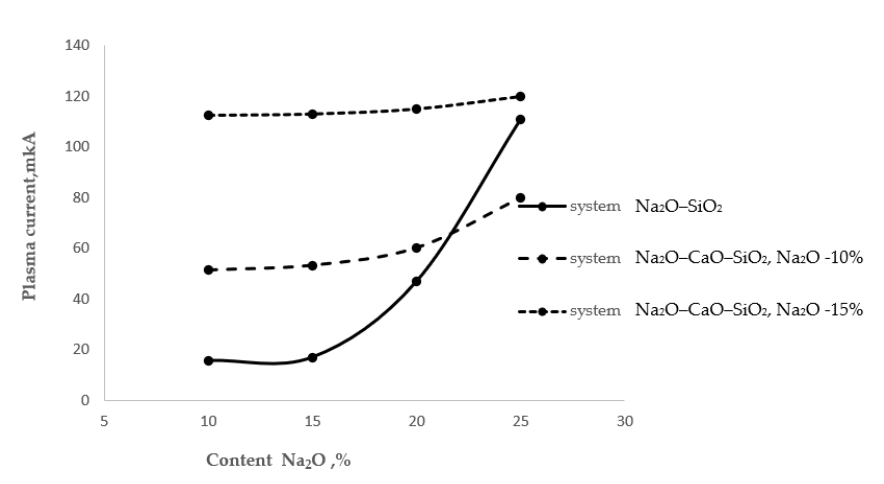
Figure 3. High-temperature extraction of alkali cations from various glasses. Figure 3. High ‐ temperature extraction of alkali cations from various glasses.